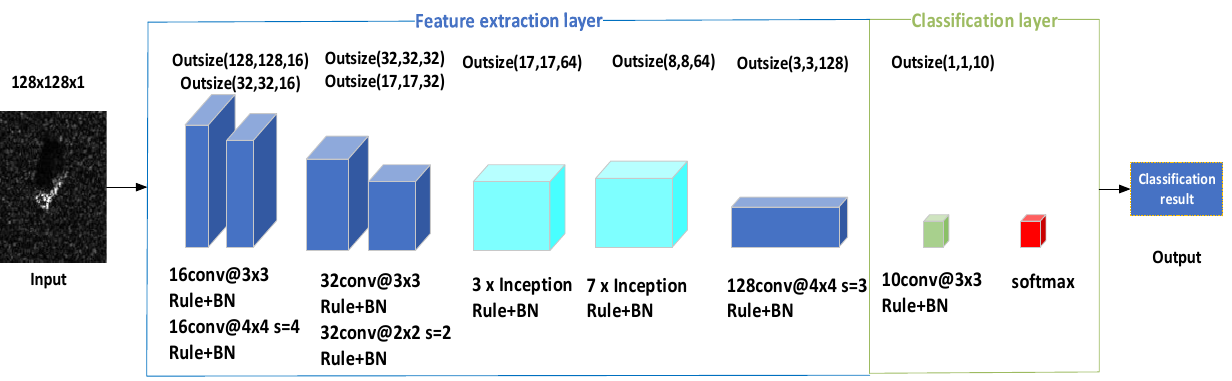
Figure 4. The structure of IFCNN in this paper.